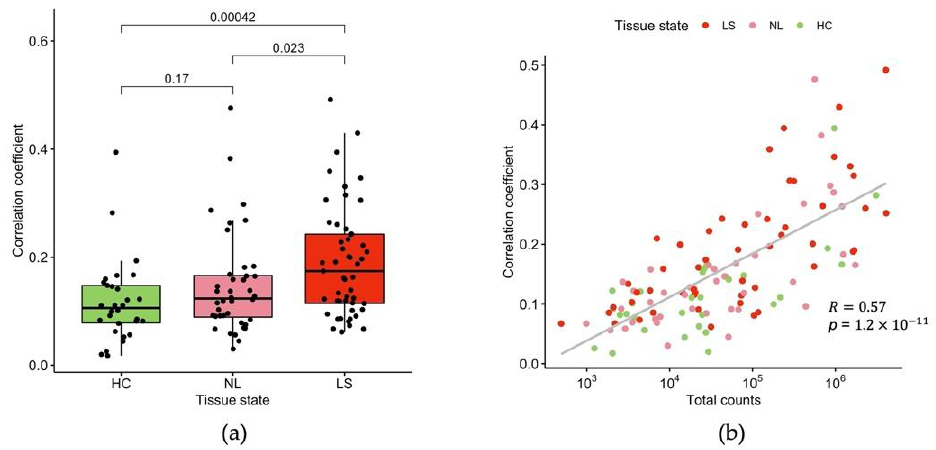
Figure 6. ( a ) Correlation between gene expression detected in tape-stripped skin and full-thickness skin punch biopsies in HC, NL, and LS skin. The p -values of the group mean comparison are shown above each contrast; ( b ) The tape strip – punch biopsy correlation increases with the total transcript counts obtained from the tape-stripped skin.